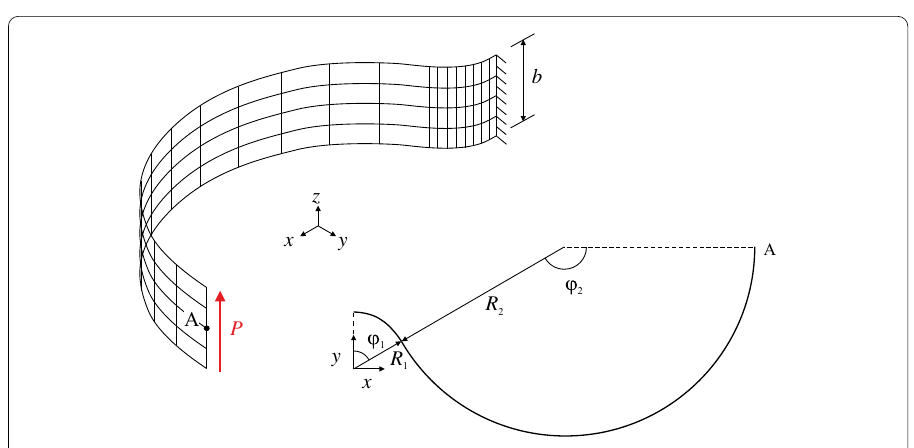
Fig. 24 Hook problem: geometry and a 4 × 8 × 12 regular